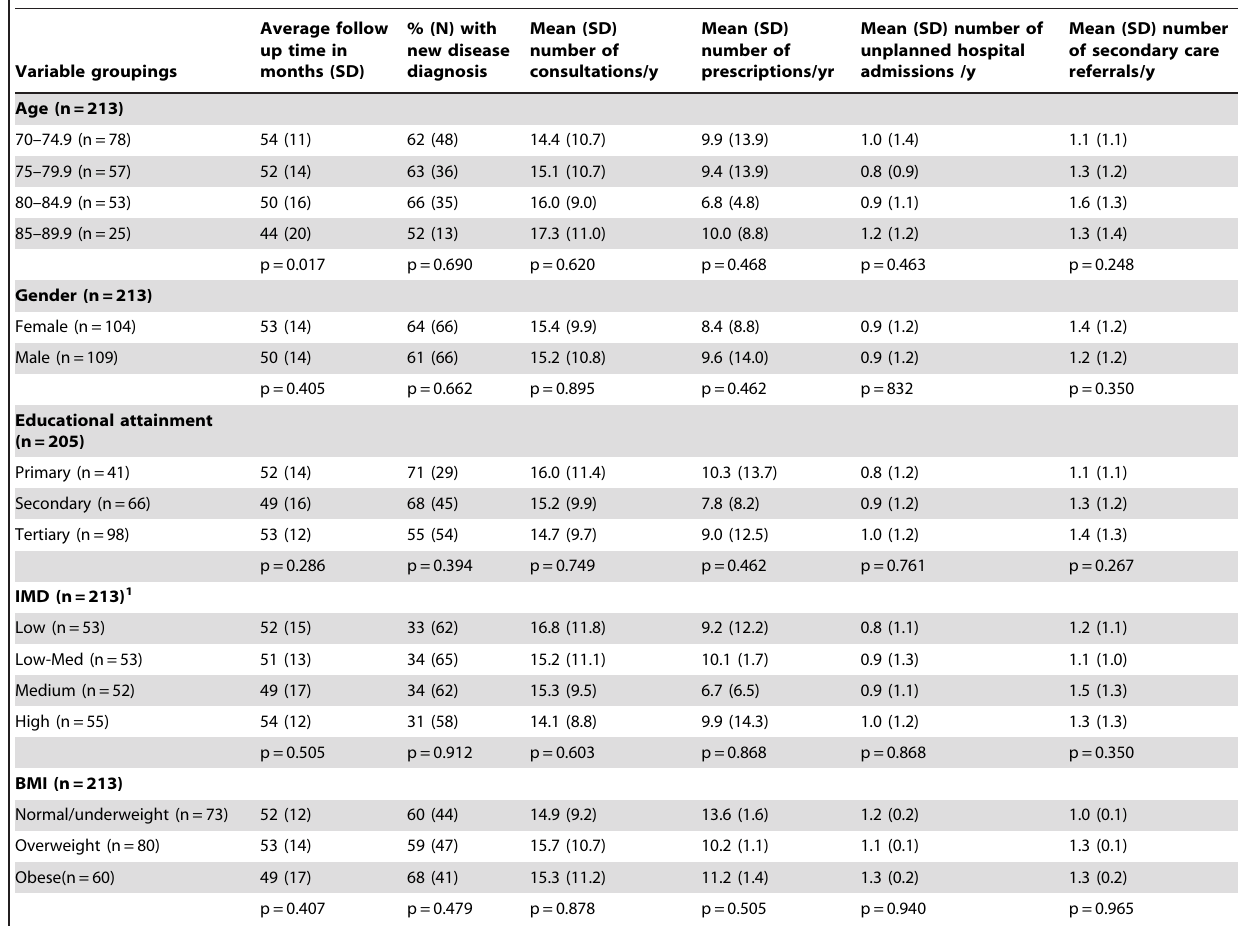
Table 1. Baseline participant characteristics, percentage with a new disease diagnoses and HSU means during follow up.